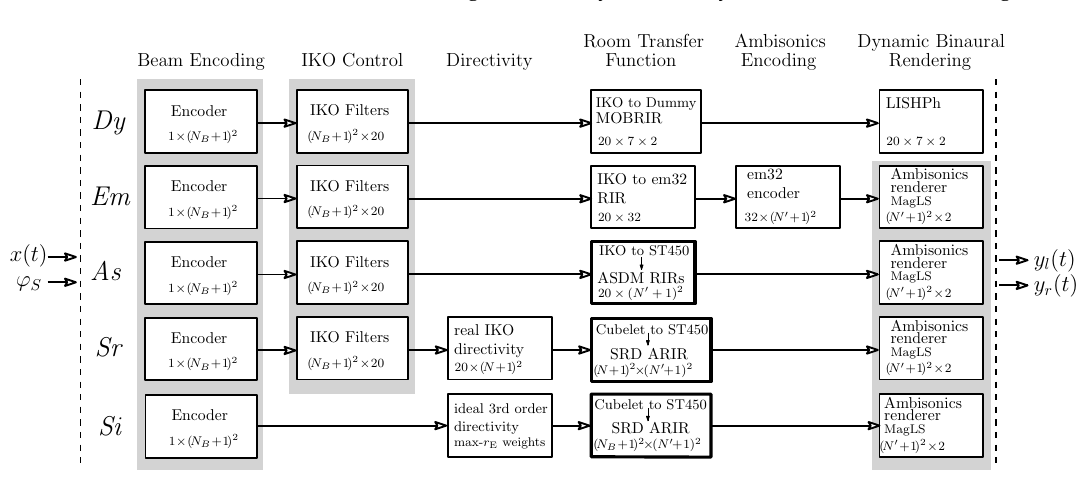
Figure 3. Auralization techniques evaluated in the listening experiment. Here x ( t ) , ϕ S , and y l ( t ) and y r ( t ) are the source signal, the beam direction, and the ear signals of the left and right ear, respectively. The auralization techniques from top to bottom are (i) dummy head BRIR ( Dy ), (ii) MIMO ARIR ( Em ), (iii) Multi ASDM ( As ), (iv) real SRD ARIR ( Sr ), and (v) ideal SRD ARIR ( Si ) auralization. Note that gray-shaded boxes indicate functional blocks which are shared between different techniques. The boxes delimited by bold lines mark techniques in which the actual Room Transfer Function is not directly measured but obtained by processing (e.g., upscaling by an ASDM method) of the underlying measurements as proposed in Section 2.2. A detailed description of the techniques can be found throughout Section